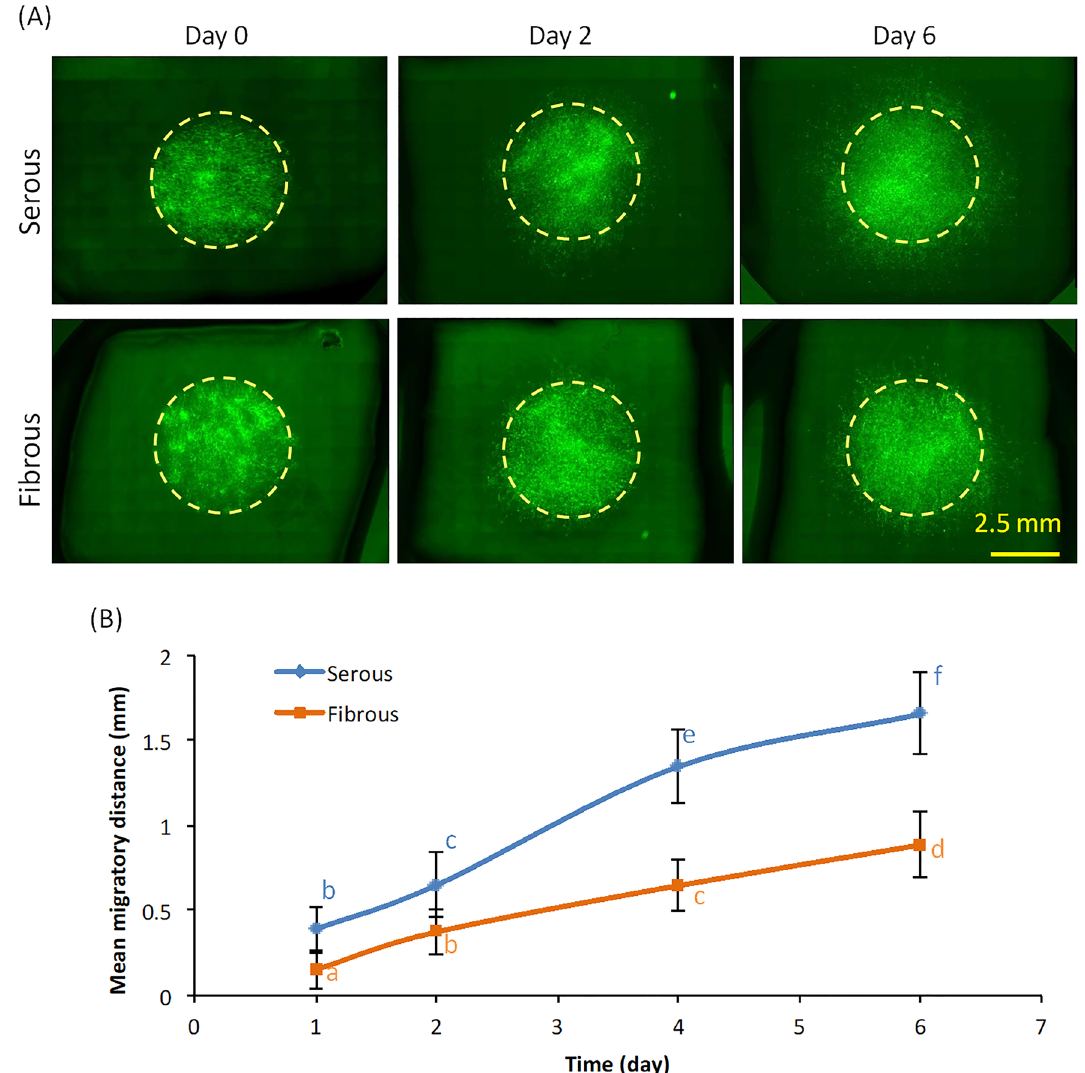
Figure 2. Effect of AR-BP sideness on cell migration. ( A ) Inverted microscopy images of cell migration at different time points (day 0, 2, 6), demonstrating greater cell migration following serous side seeding than fibrous side seeding. Scale bar: 2.5 mm; ( B ) Quantification of cell migration over time in culture, showing migration rate following serous seeding is greater than that of fibrous seeding. Statistical analysis was performed using two-way repeated measures ANOVA and Tukey’s multiple comparisons post hoc test. Data points that are not connected by the same lower case letter are statistically different. (n = 6 scaffolds per